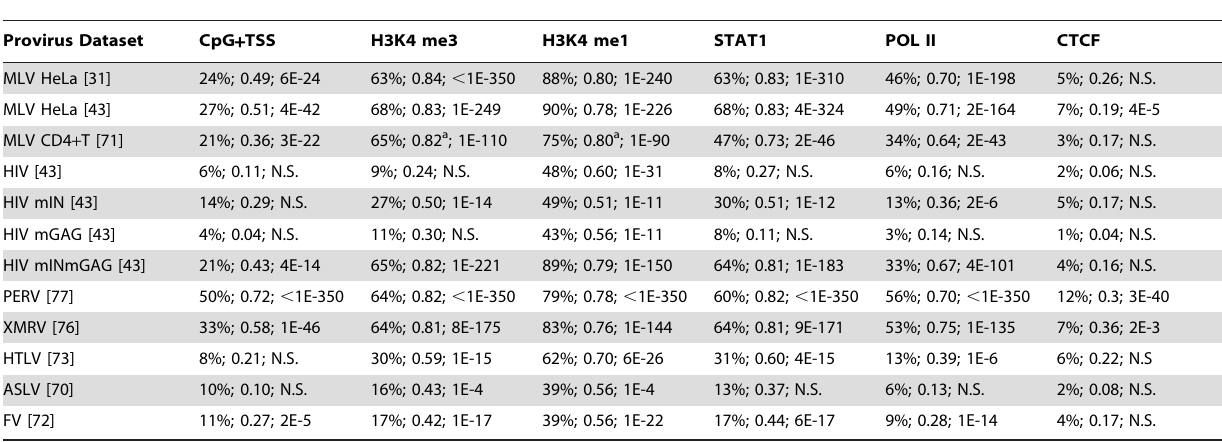
Table 3. Association of retroviral integration sites with some ChIPSeq profiles.